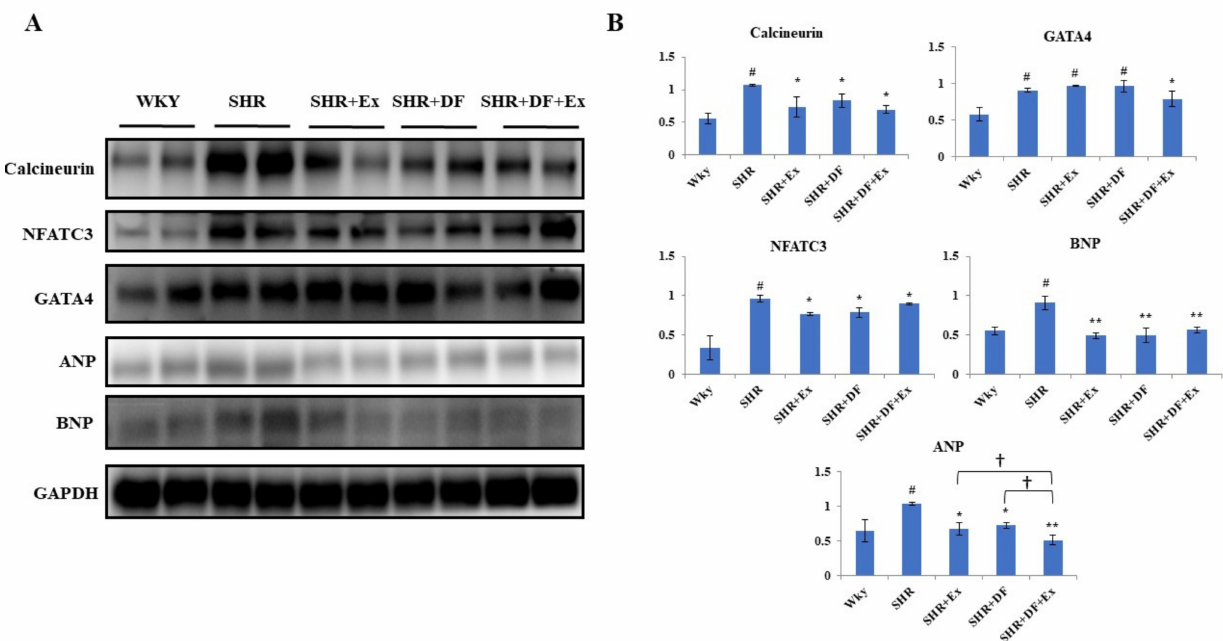
Figure 8. Effect of DF and exercise on cardiac hypertrophy markers. ( A ) Expression of cardiac hypertrophy-associated markers such as calcineurin, NFATC3, GATA4, ANP, and BNP proteins. ( B ) Graph showing densitometric analysis. Each bar represents mean ± SD ( n = 8). # p < 0.01 compared to WKY, * p < 0.05 and ** p < 0.01 compared to SHR, † p < 0.05 compared to SHR + EX and/or SHR + DF.